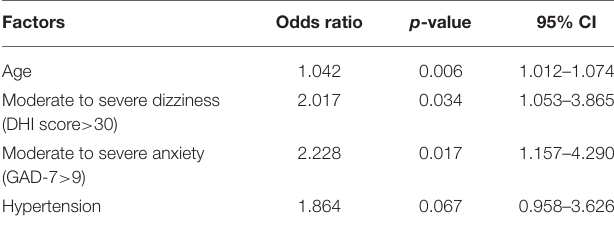
TABLE 3 | Multivariate analysis of factors associated with residual dizziness in middle-aged and older-aged patients. Factors Odds